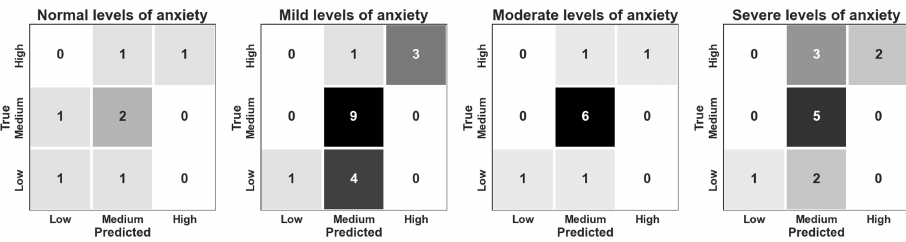
Figure 7. The confusion matrix results of the practitioner’s level of competence (low, medium, high) based on the patient’s level of anxiety (normal, mild, moderate and severe).